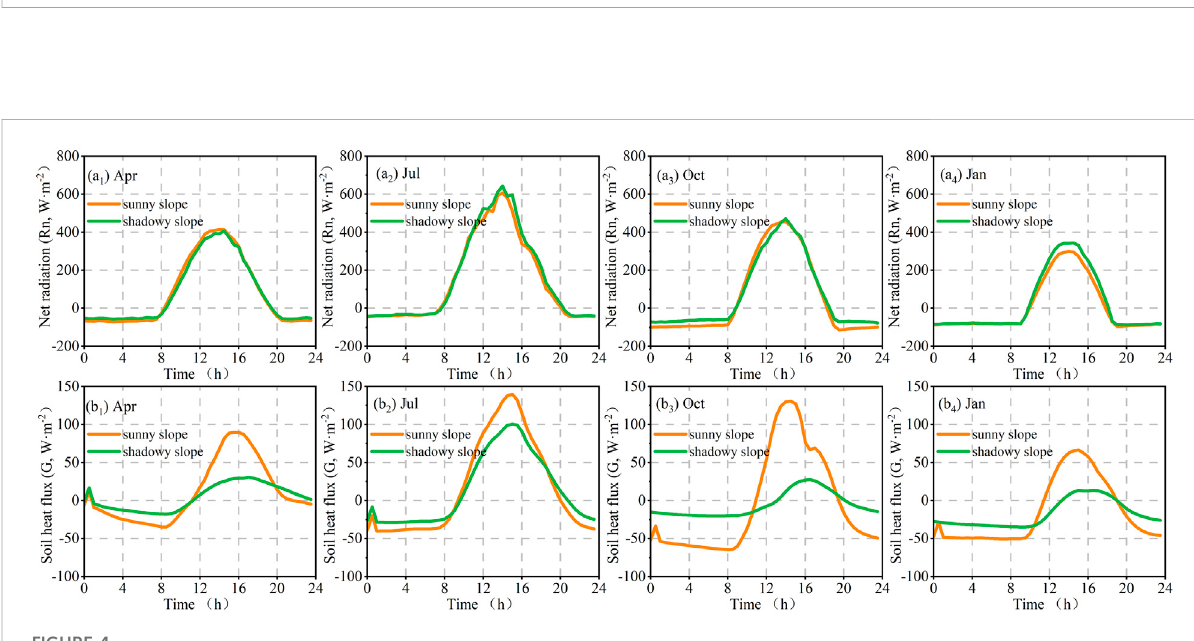
FIGURE 4 Characteristics monthly mean daily variation of net radiation and soil heat fl ux in different stages on the shadowy and sunny slopes (a 1 ,b 1 ) Thawing stage; (a 2 ,b 2 ) Complete thawing stage; (a 3 ,b 3 ) Freezing stage; (a 4 ,b 4 ) Complete freezing